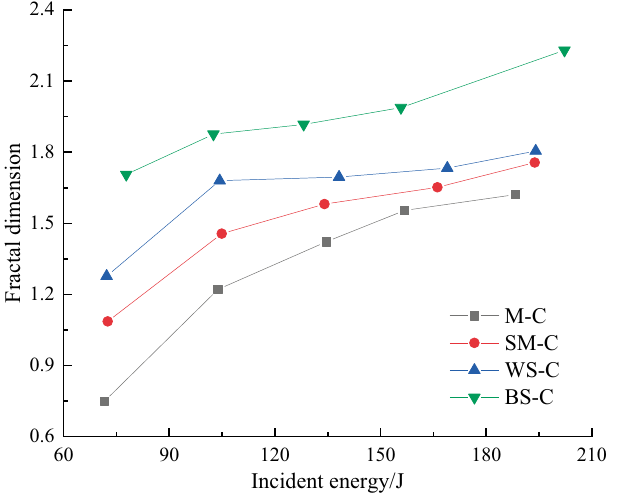
Figure 11. Relationship between the fractal dimension and the incident energy of CRCB specimens.